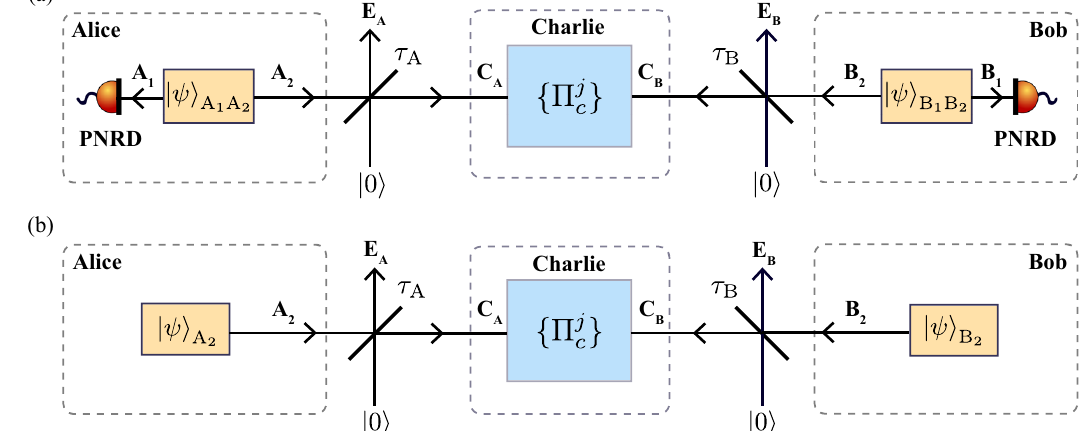
Fig. 1 Equivalent representations of the protocol. a Entanglement-based scheme where both Alice and Bob send optimised states with n max ¼ 7 to Charlie while keeping one arm of their states to themselves denoted as modes A 1 and B 1 , respectively, and measure the number of photons using photon-number resolving detectors (PNRDs). Charlie interferes modes A 2 and B 2 coming from Alice and Bob and performs a coherent total photon number measurement. b Prepare-and-measure scheme where Alice and Bob send single-mode states to Charlie where they encode the key information on the single mode Fock state one at a time. Charlie then performs a total photon number measurement in his station on the modes that Alice and Bob